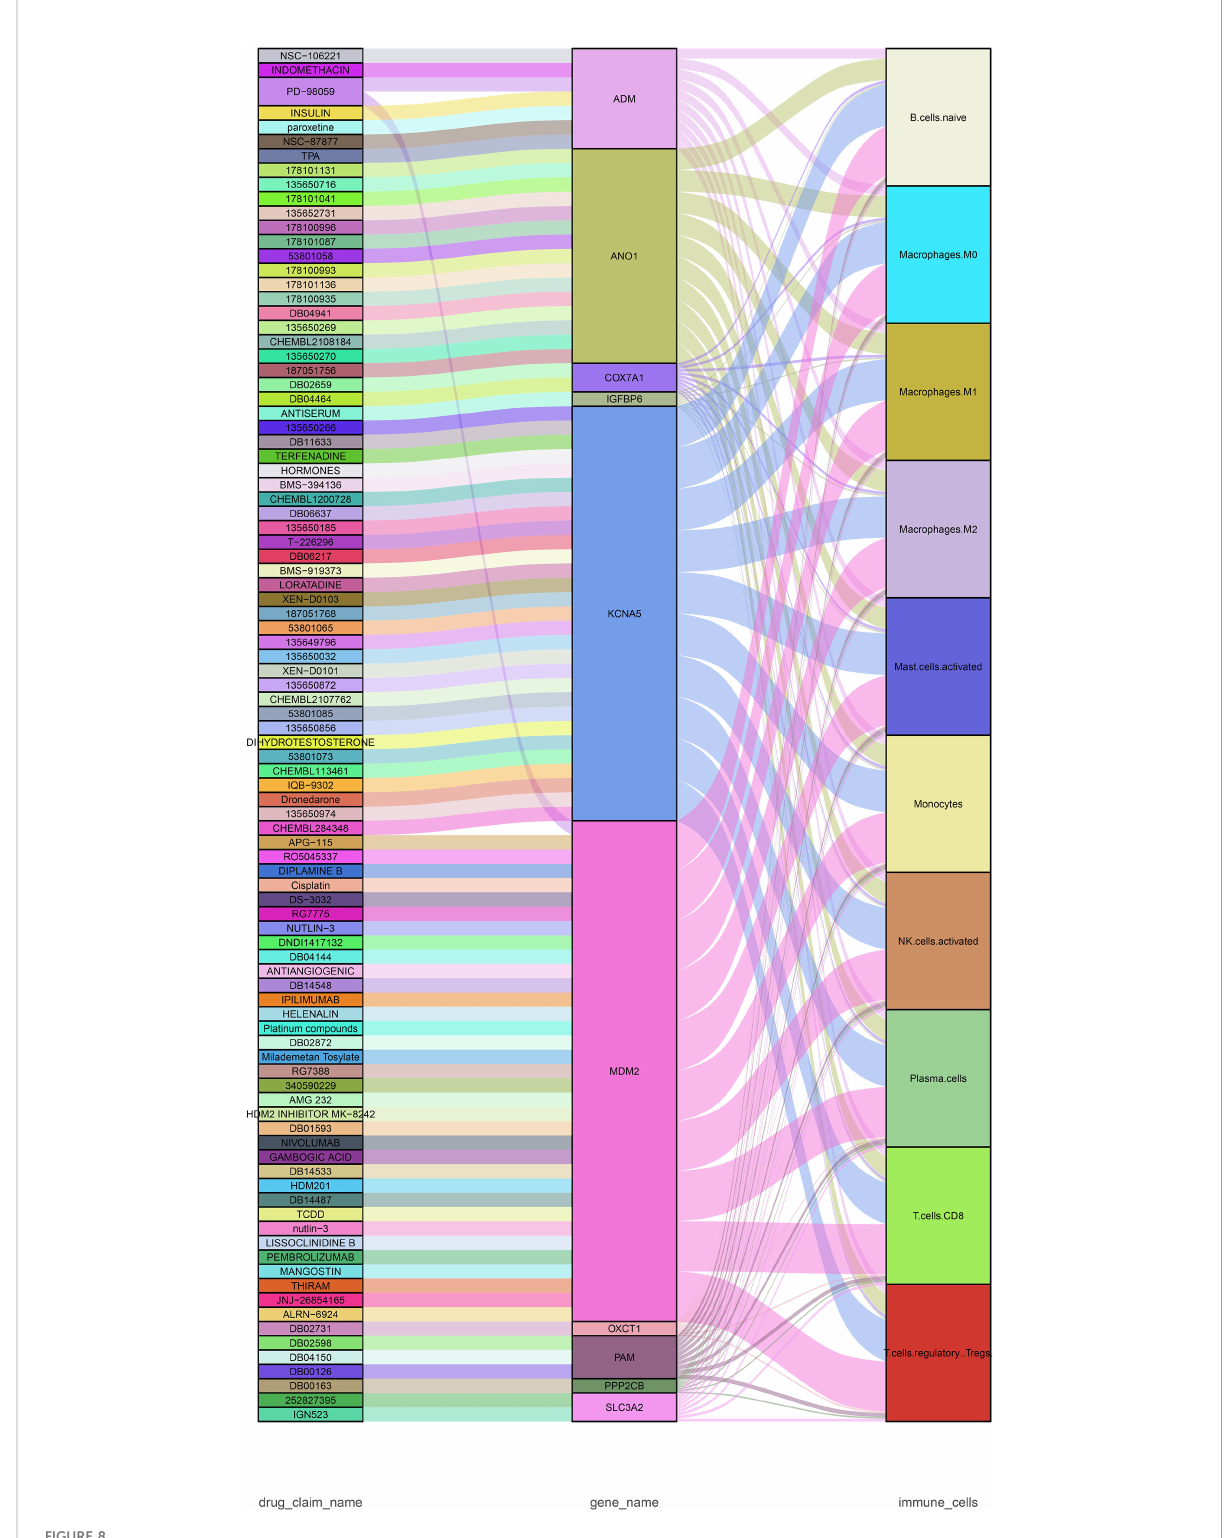
FIGURE 8 Sankey diagram showing the fl ow among drugs, genes, and immune cells. The drug – gene interaction was obtained from DGIdb (https://www.